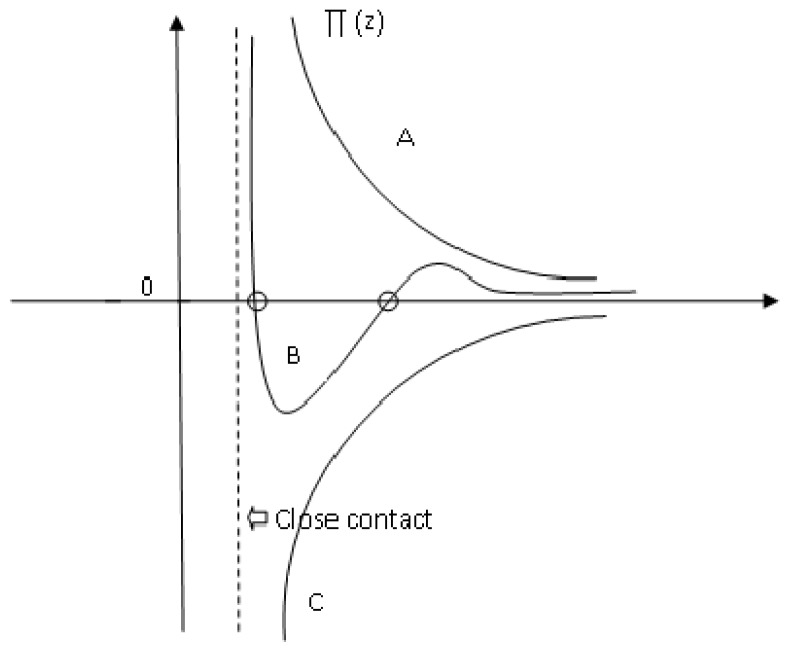
Dependence of disjoining pressure on film thickness and type of force involved. Curve (A) corresponds to a repulsive force and is a wetting case. Curve (C) is an attractive force and a non-wetting situation, and curve (B) corresponds to a metastable film (Reproduced by permission of Elsevier [234]).